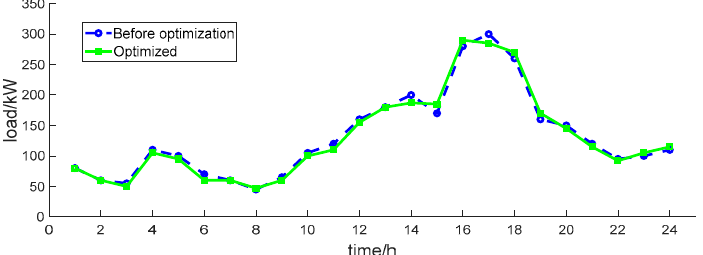
Figure 10. Air conditioning + washing machine + dishwasher (corrected BC6) trading chain setting power.